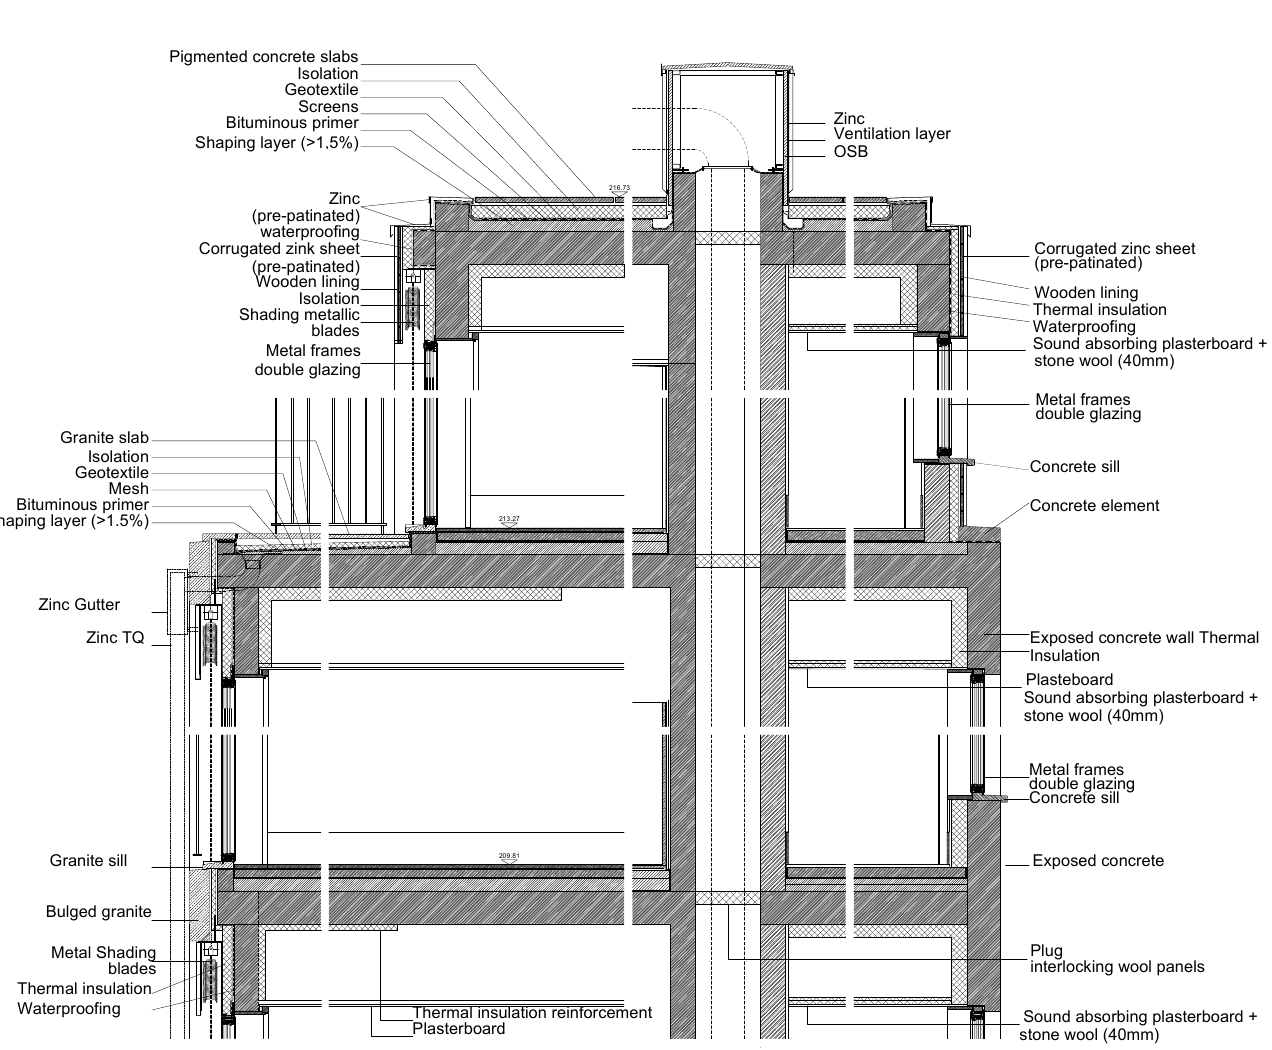
Figure 28. Braga. Constructive section (new building).